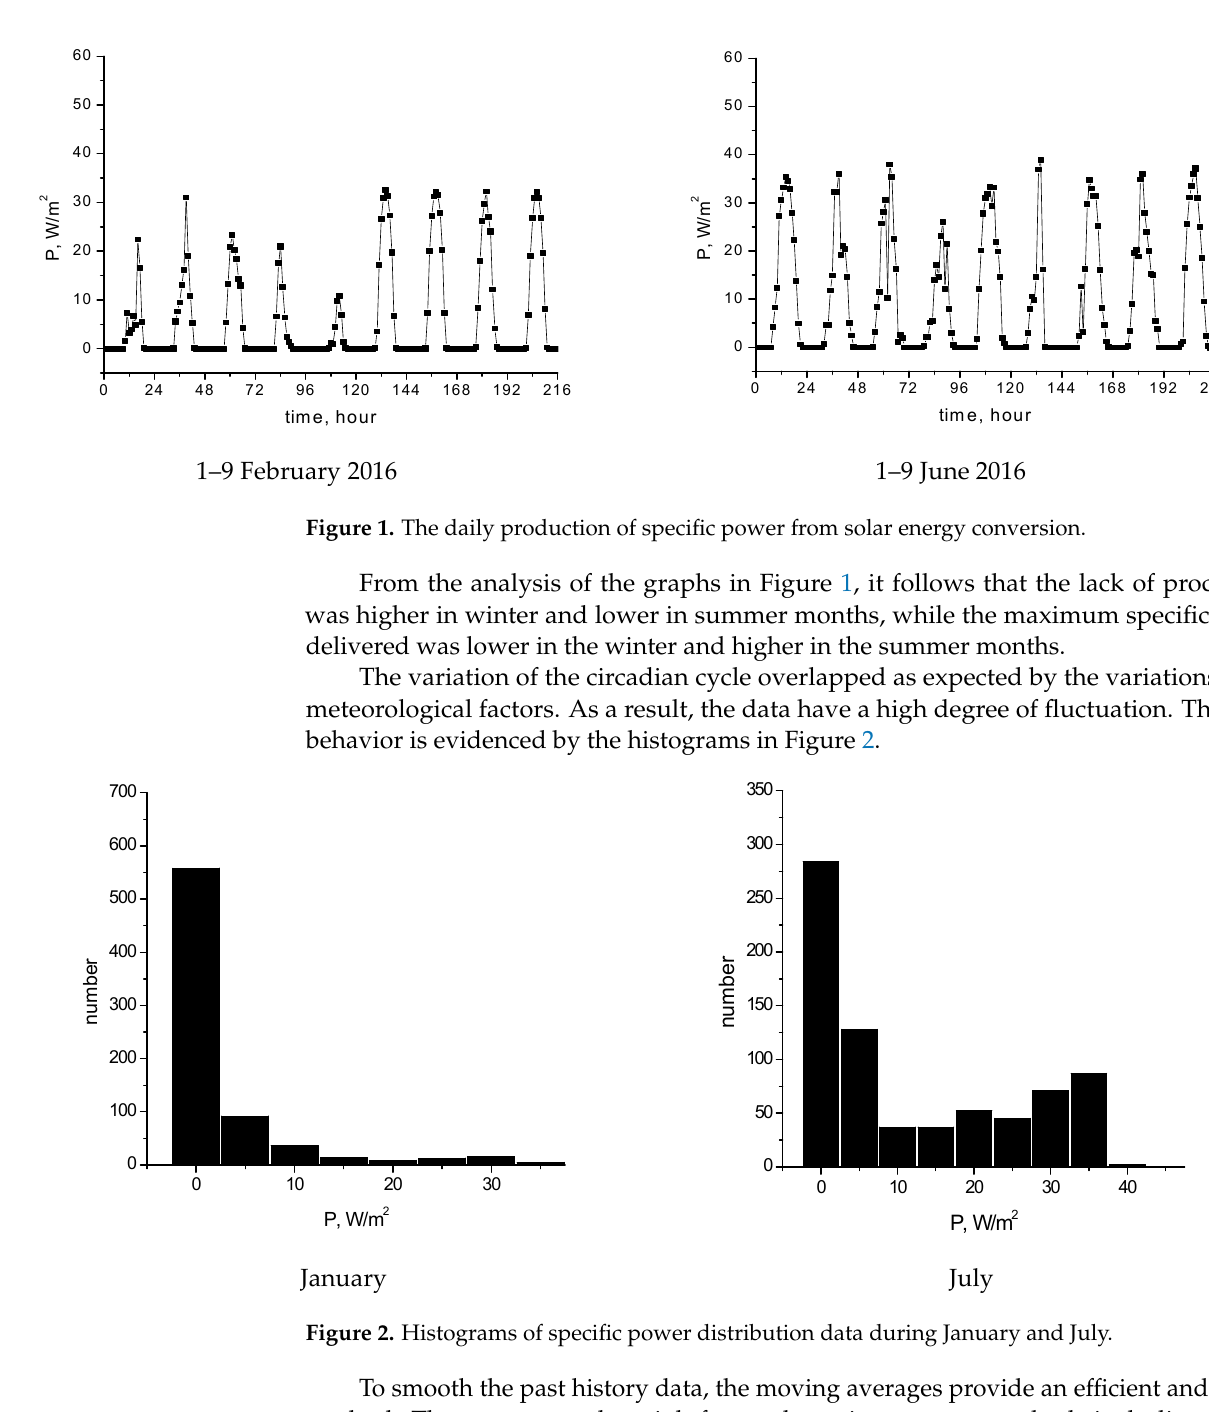
Figure 2. Histograms of specific power distribution data during January and July.